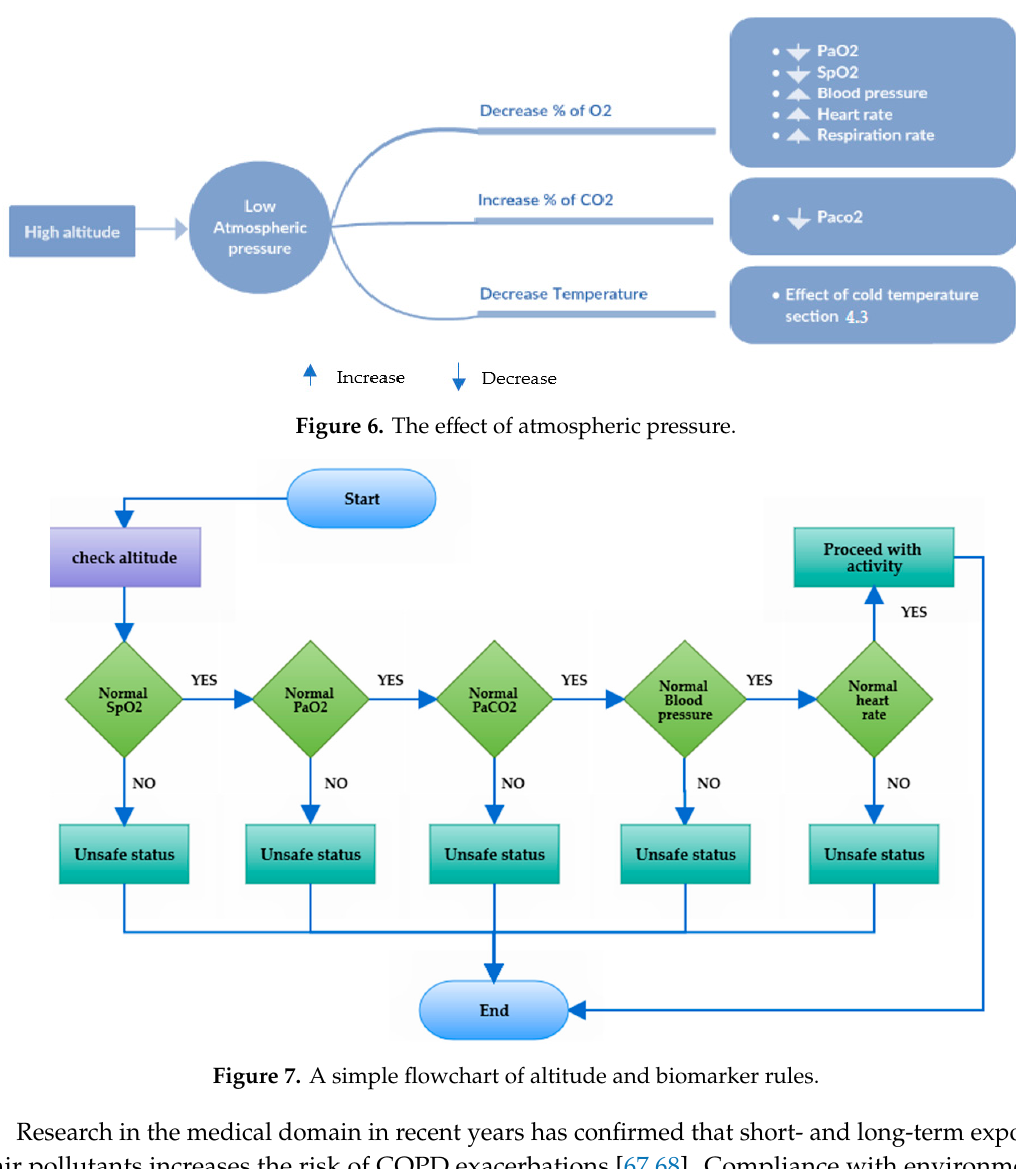
Figure 7. A simple flowchart of altitude and biomarker rules.